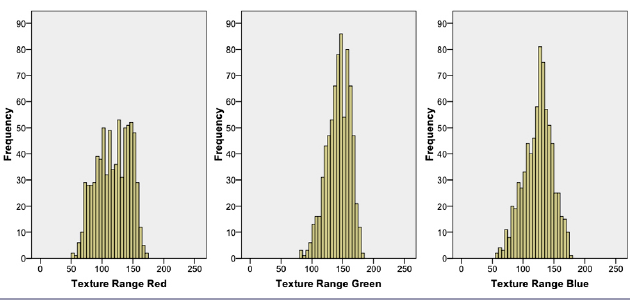
Fig. 7 . Frequency histograms showing the distribution of values for the “texture range” attribute, used as a proxy for magnitude of contrast between object and background, in each of the three spectral bands among 744 manually identified Lesser Snow Geese ( Chen caerulescens caerulescens ) in 5-cm resolution aerial imagery. Contrast is sharpest and most consistent in the green band, and least consistent in the red band.